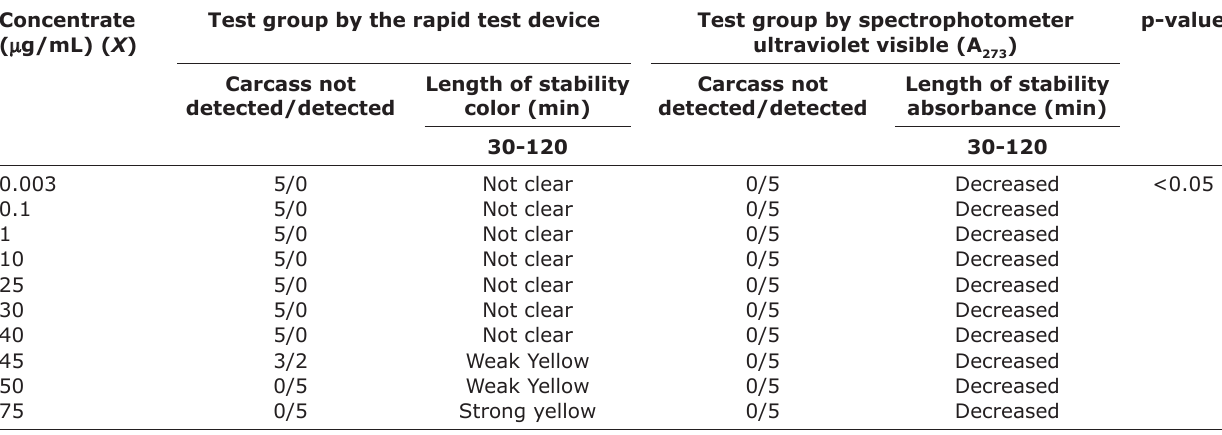
Table-2: Comparison of the findings of the precipitation-based tetracycline rapid test devices with other rapid test devices for detection of tetracycline. No. Model of rapid test devices